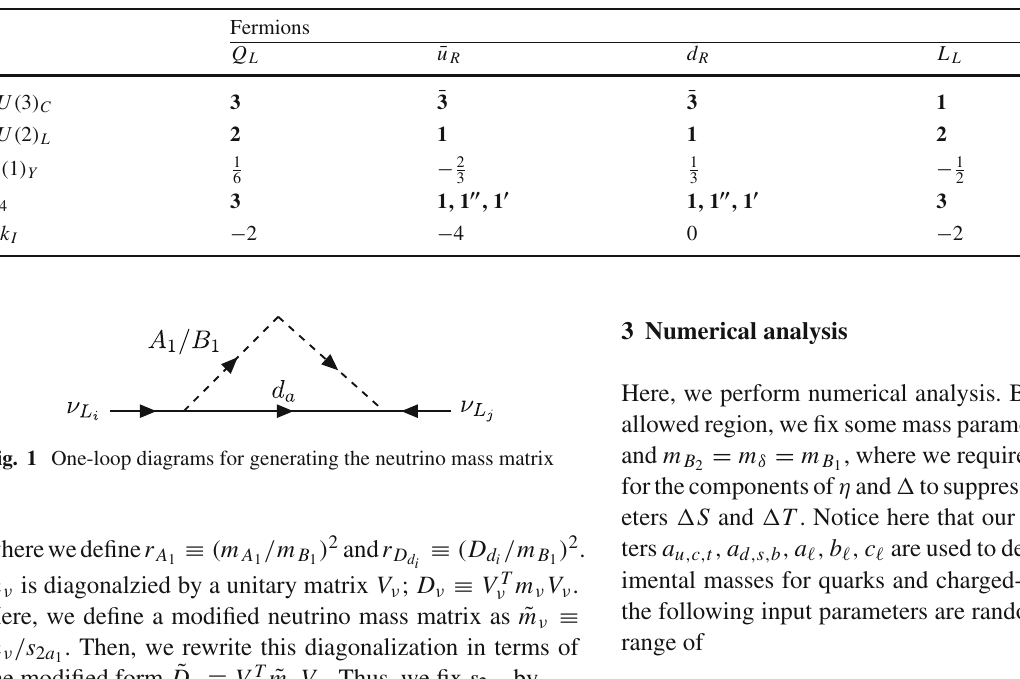
Table 2 Charge assignments of the SM fermions under SU ( 3 ) C × SU ( 2 ) L × U ( 1 ) Y × A 4 where k I is the number of modular weight